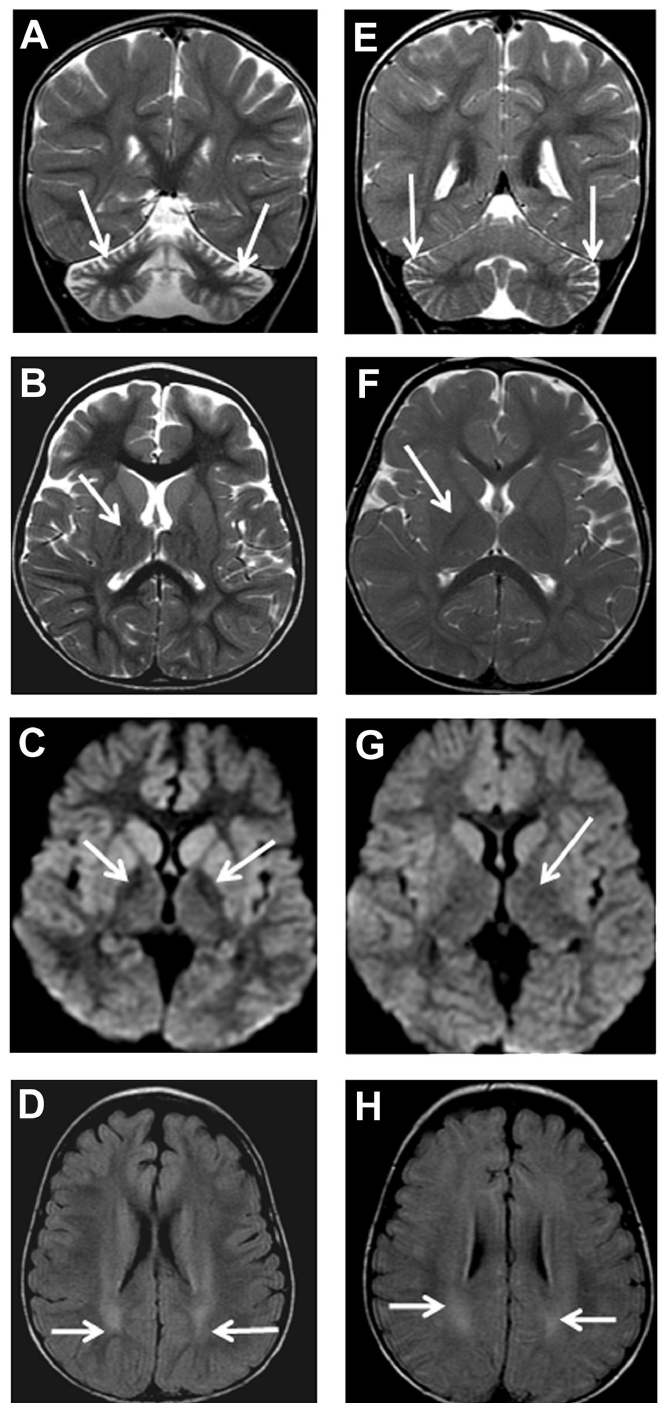
Figure 1. Patient F2 (P1) MRI, age 3 years 3 months (A-D). Coronal T2-weighted (A), axial T2-weighted (B), axial diffusion (C), axial FLAIR (D) showing cerebellar atrophy (arrows) with widening of cerebellar folia (A), T2 normal signal intensity (arrows) of globus pallidus (B), highlighted subtle iron deposition at globus pallidi (arrows) as reduction in signal intensity (C), and high signal intensity (arrows) at cerebral white matter (D). Patient F2 (P2) MRI, age 1 year 3 months (E-H)). Coronal T2-weighted (E), axialT2- weighted (F), axial diffusion (G), axial FLAIR (H) showing mild cerebellar atrophy (arrows) with mild widening of cerebellar folia (E), normal signal intensity (arrows) of globus pallidus (F and G), and high signal intensity (arrows) at cerebral white matter (H). doi: 10.1371/journal.pone.0076831.g001 PLOS ONE |